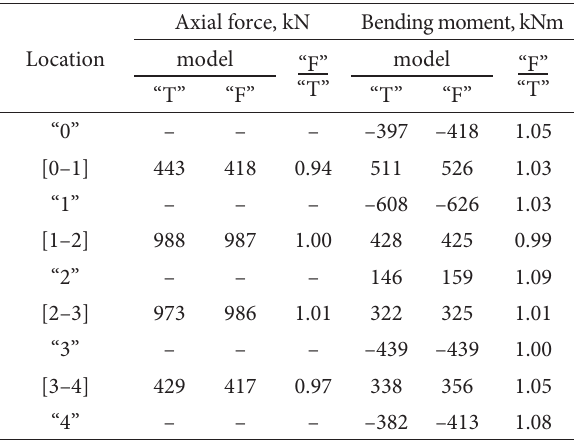
Table 6. Comparison of internal forces in rigid flange based on model “T” and “F” analyses Axial force, Location